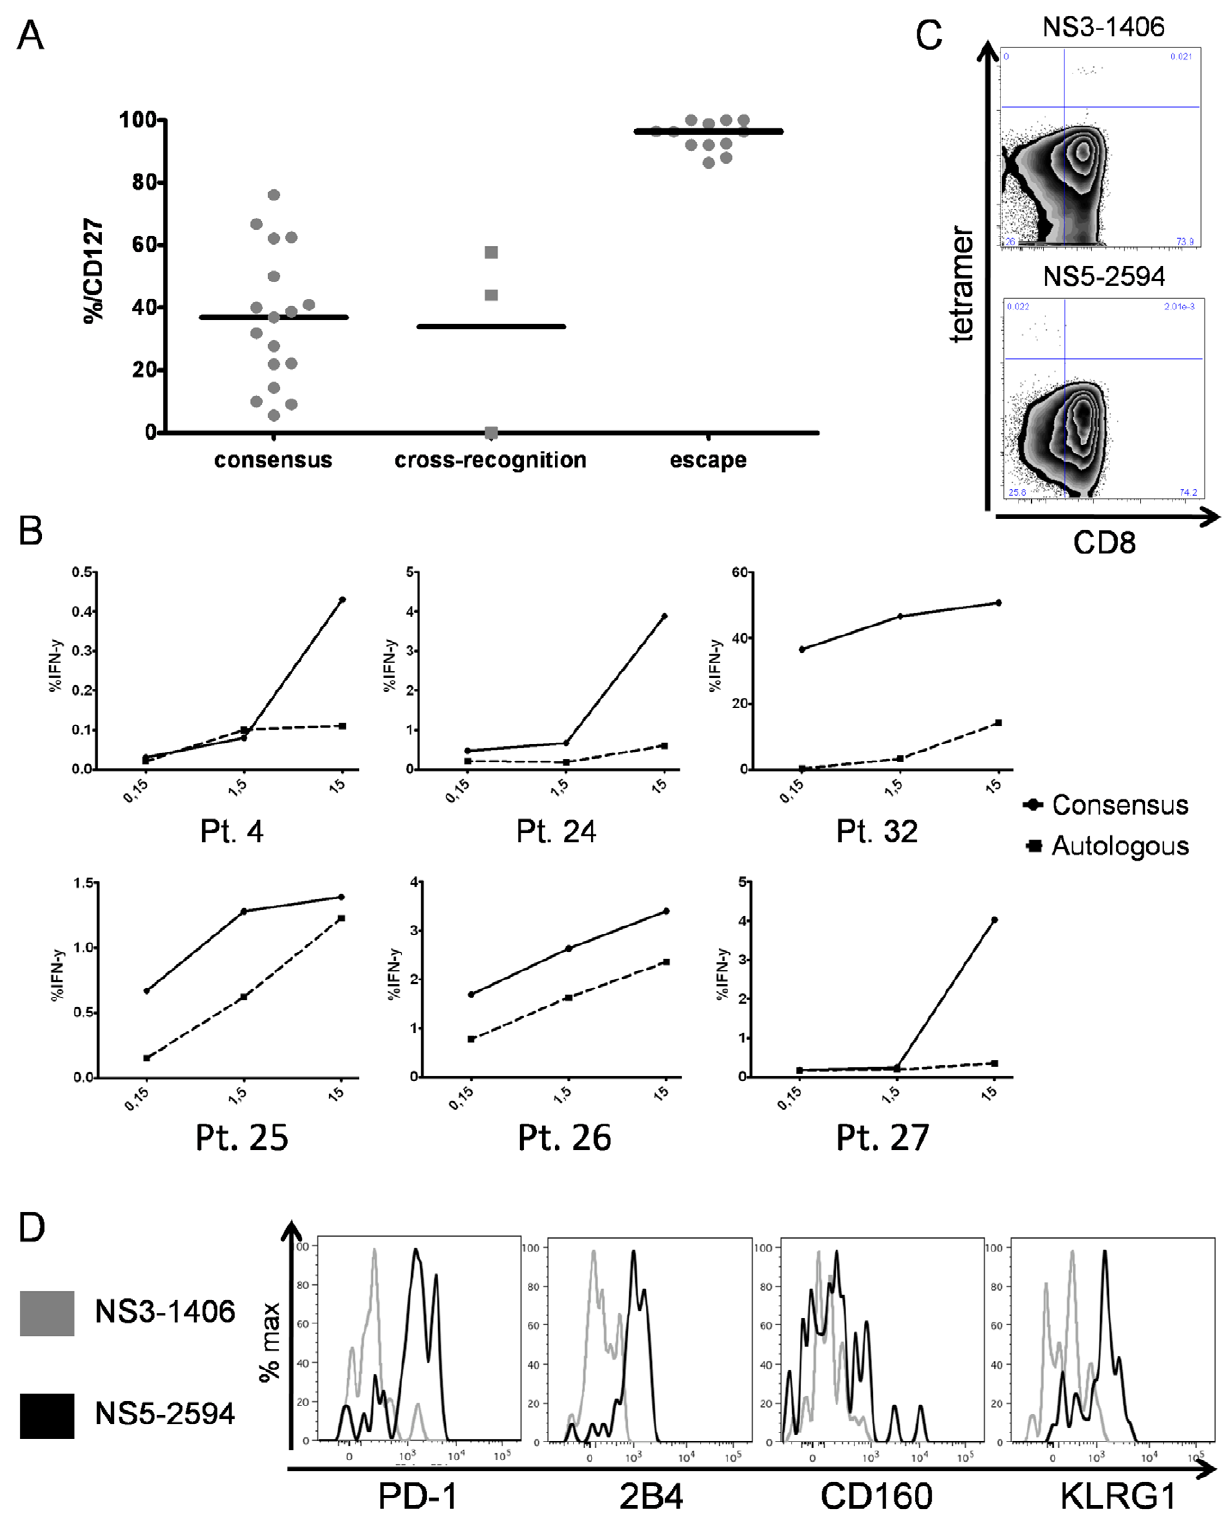
Figure 8. Inhibitory receptor expression is linked to recognition of viral antigen. (A) CD127 expression of HCV-specific CD8 + T cells grouped depending on the autologous virus sequence. Cross-recognition was defined as sequence variation from consensus that has been previously shown to be cross-recognized [39]. (B) PBMC of patients with variant autologous sequences (see table 2) were stimulated for IFN- c expression after short term culture with different concentrations of consensus peptide (black line) or variant autologous peptide (dashed line). Representative diagrams are shown for pts. 4, 24–27 and 32. Frequency of IFN- c expression is shown on the y axis, peptide concentration ( m M) on the x axis. Viral escape is indicated by the strongly reduced IFN- c production after stimulation with the autologous peptide sequence. (C) Divergent